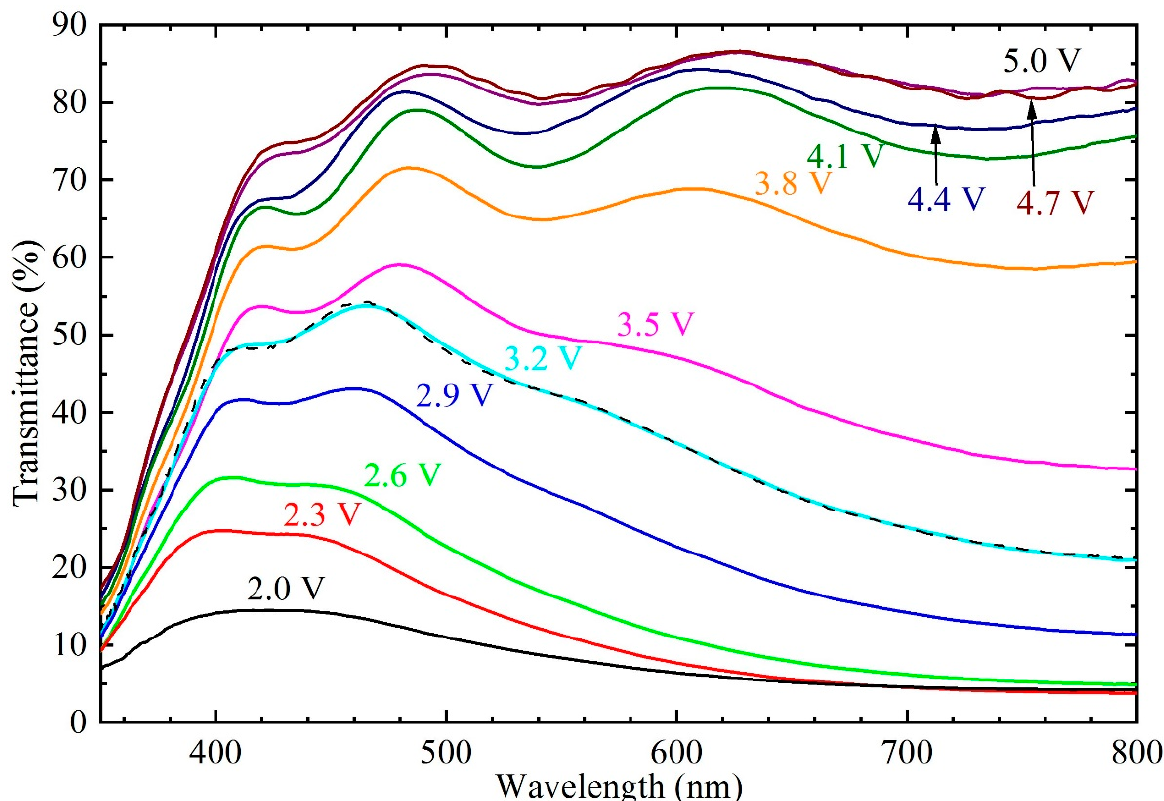
Figure 2. Spectral optical transmittance for a ~300-nm-thick film of HWO x at applied potentials between 2.0 and 5.0 V vs. Li/Li + . The optical transmittance of the as-deposited film is given by the dashed curve.